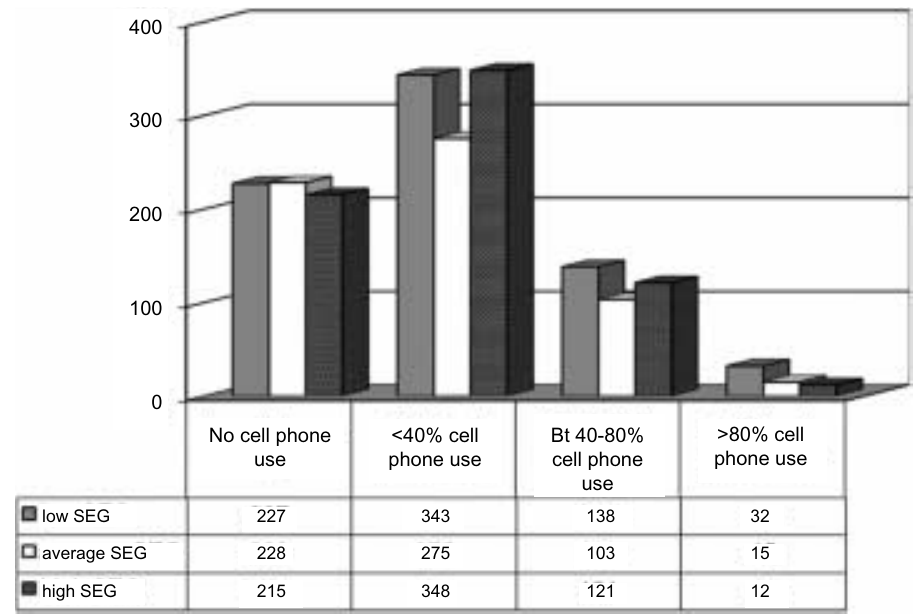
Figure 5. Academic use of cell